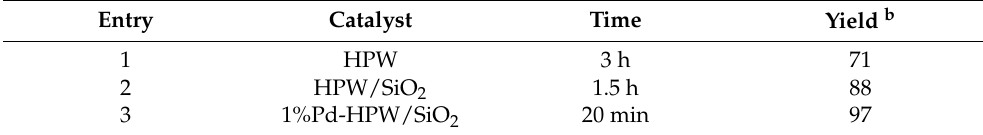
Table 5. Catalyst optimization for the synthesis of the model octahydroquinazolinone 4a a . Entry Catalyst Time Yield b